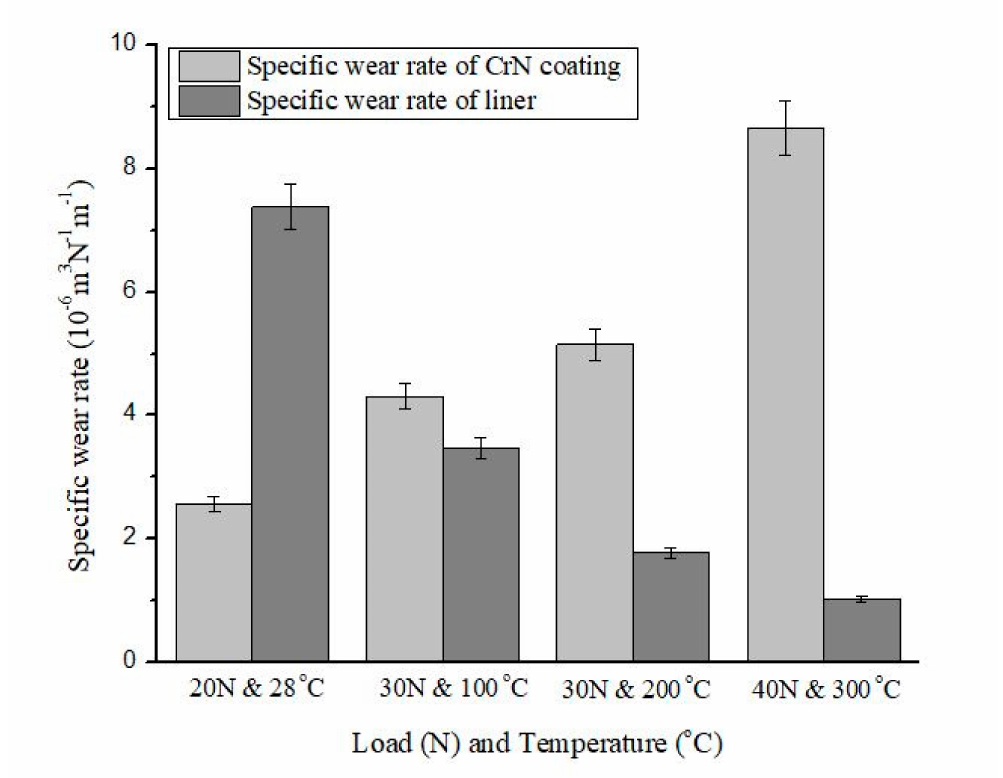
Figure 6. Specific wear rate of coated sample and counter-body at di ff erent load and